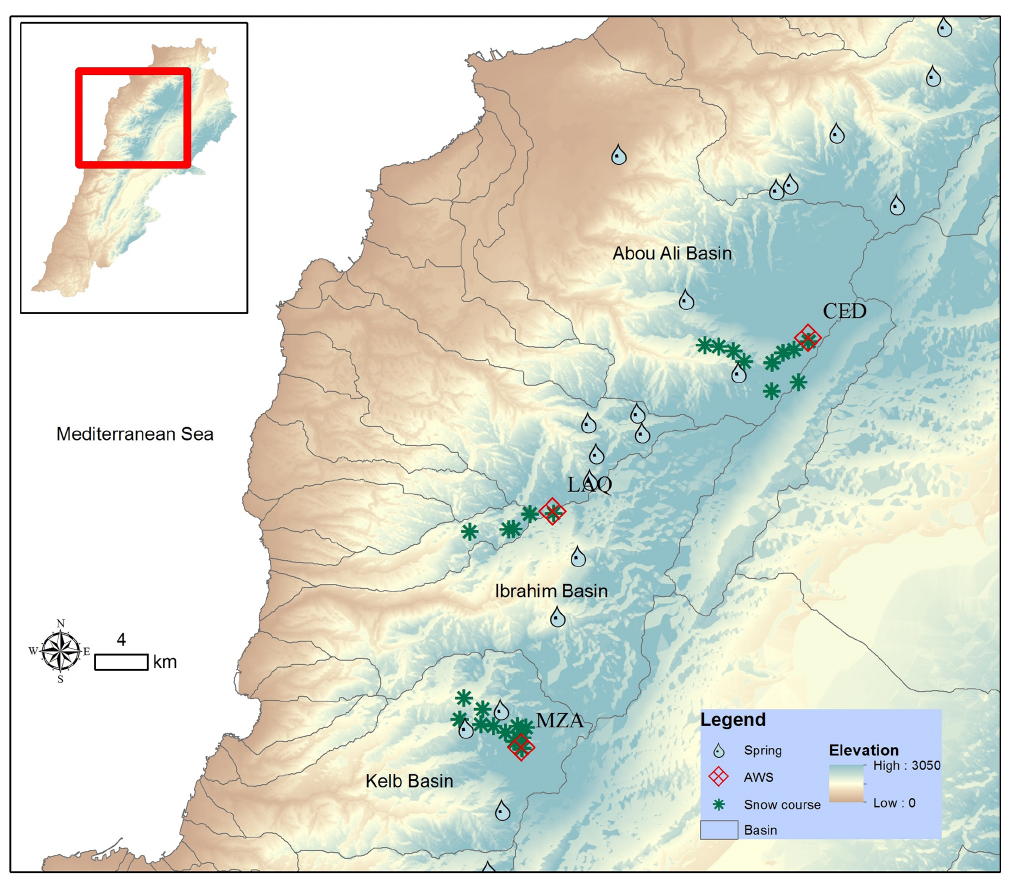
Figure 1. Location of the three study river basins in Mount Lebanon and the location of the three automatic weather stations (AWSs). Points indicates the location of the snow courses. Snow height (HS), snow density, and snow water equivalent (SWE) were measured at 30 snow courses for the two snow years (2014–2016): 9 snow courses at Cedars between 1800 and 2900ma.s.l., 15 snow courses between Faraya and Mzar between 1350 and 2350m, and 6 snow courses between Ehmej and Laqlouq (elevation range between 1350 and